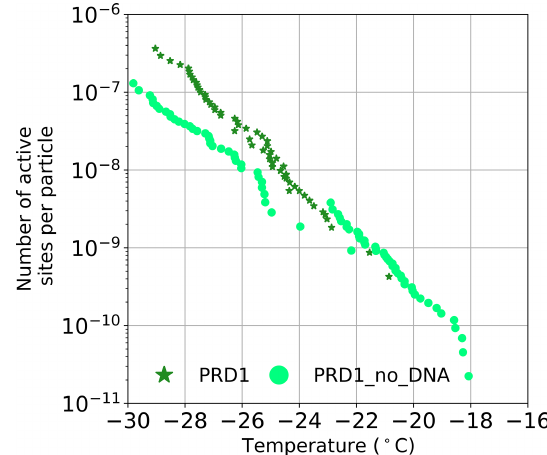
Figure 3. The number of active sites per particle ( n n ) for PRD1 with and without DNA. Temperature values have been corrected for freezing point depression of